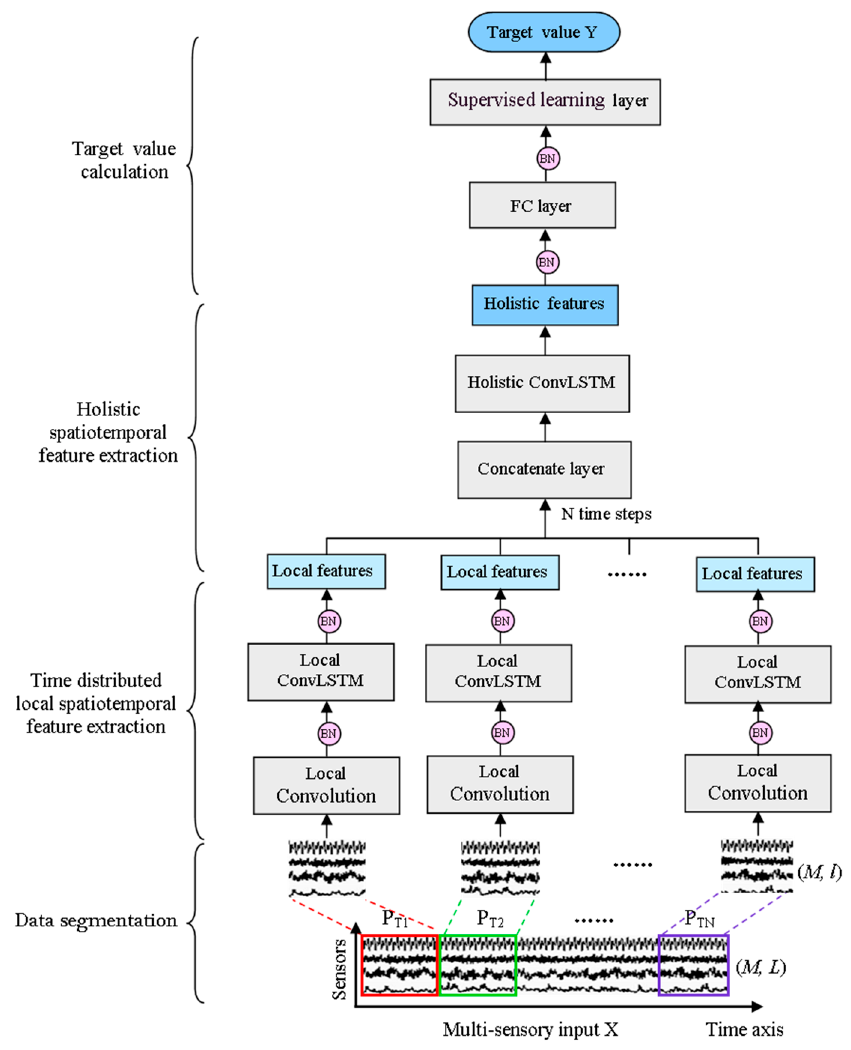
Figure 3. The framework of the proposed TDConvLSTM model (TDConvLSTM).